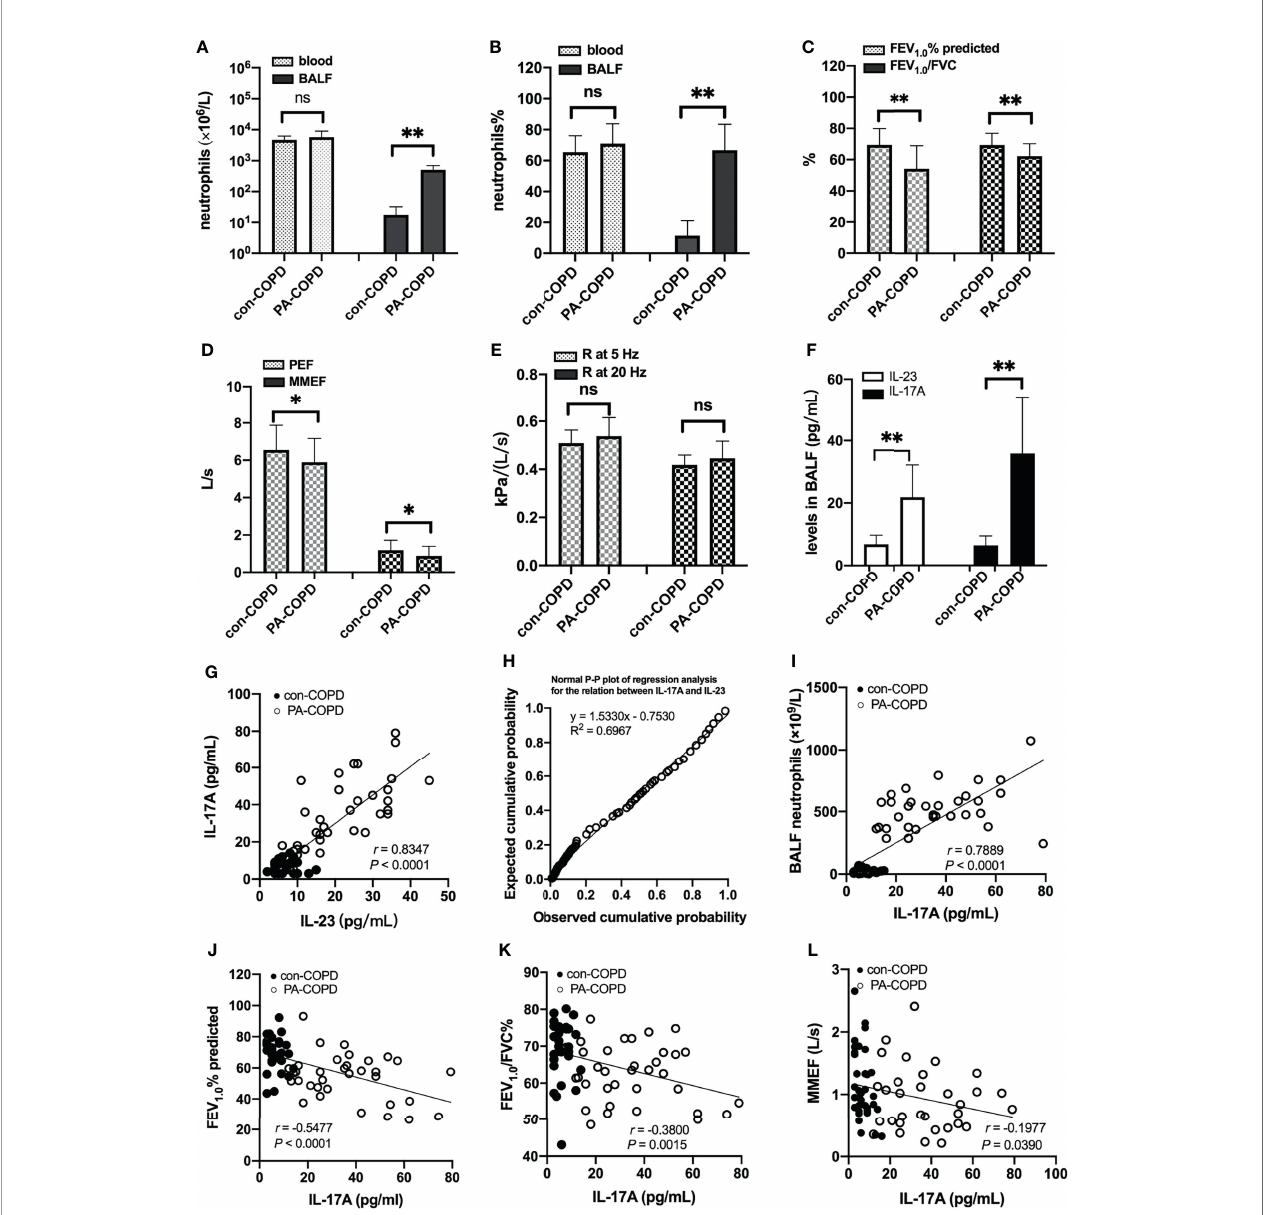
FIGURE 1 | Neutrophils, lung function and BALF IL-23/IL-17A levels between patients with stable COPD (con-COPD, n = 33) and patients with P. aeruginosa - infected COPD (PA-COPD, n = 34). PA-COPD patients had higher absolute and percent numbers of neutrophils in BALF, but not in blood (A, B) . Forced expiratory volums (C) , expiratory fl ows (D) and forced oscillation tests (E) were compared between con-COPD and PA-COPD patients. IL-23 and IL-17A levels were signi fi cantly elevated in patients with PA-COPD (F) . Data were presented as mean ± SD. *P < 0.05, ** P < 0.01, ns, non-signi fi cant. Correlation analysis showed that there was a notably positive correlation between the two cytokines (G) , and further regression analysis revealed that IL-23 might be an important factor contributing to elevation of IL-17A (H) . There was also a signi fi cantly positive correlation between IL-17A levels and absolute neutrophil numbers in BALF (I) . The spirometry results, including FEV 1.0 % predicted (J) , FEV 1.0 /FVC% (K) and MMEF (L) were negatively correlated with the levels of IL-17A. BALF, bronchoalveolar lavage fl uid; COPD, chronic obstructive pulmonary disease; IL, interleukin; FEV 1.0 , forced expiratory volume in one second; FVC, forced vital capacity; MMEF, maximal mid- expiratory fl